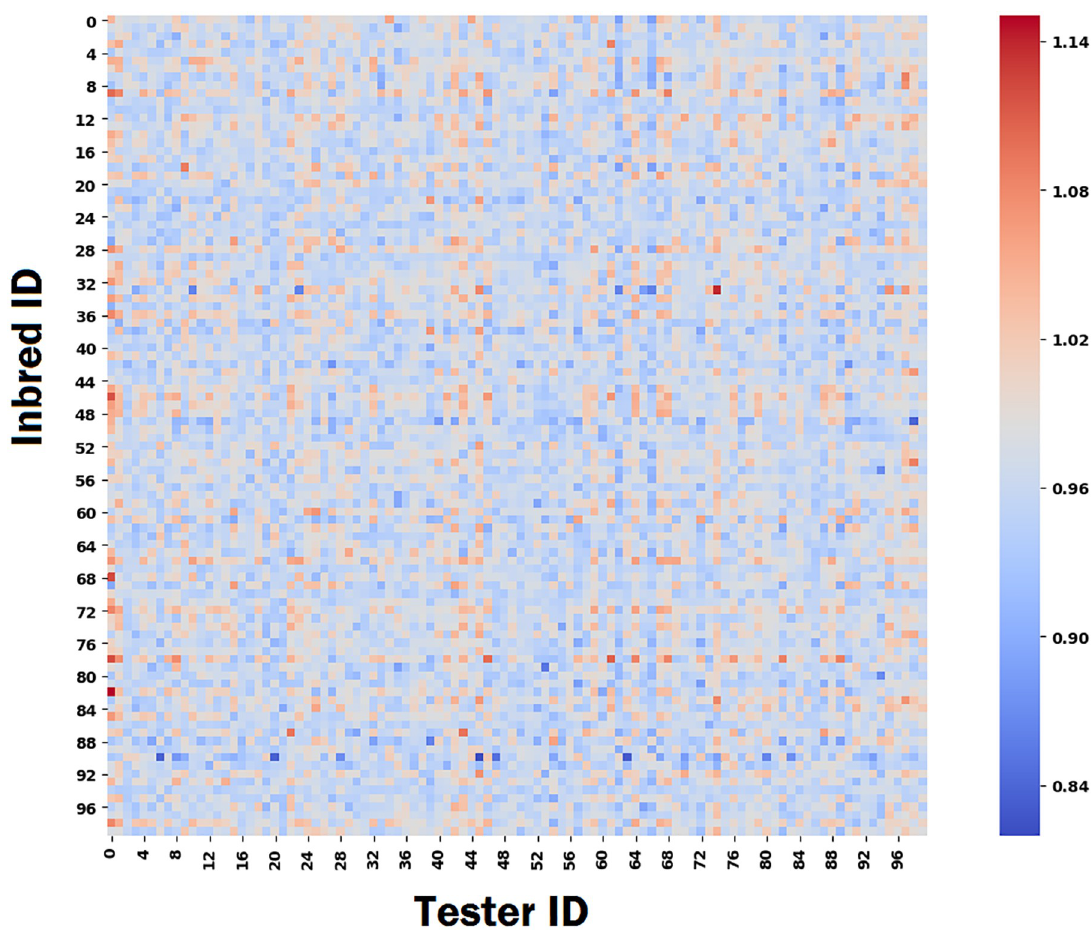
Fig 4. The heatmap of the average yield performance of all cross combinations of 100 inbreds and 100